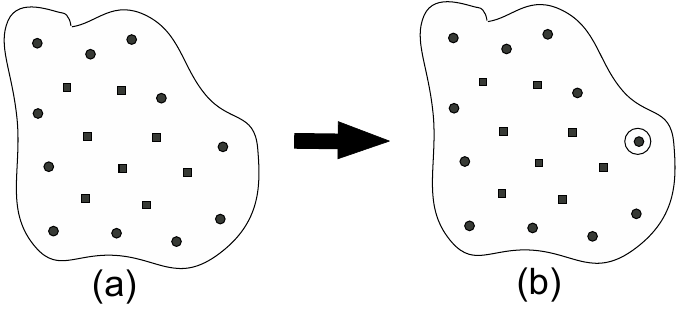
Figure 1. ( a ) Classification of sampled points in the reaction coordinate space. The black circles are the sampled points that exist in the border region. ( b ) The black circle point having the lowest PMF value is chosen as the parent point, around which new points will be created in step (2).